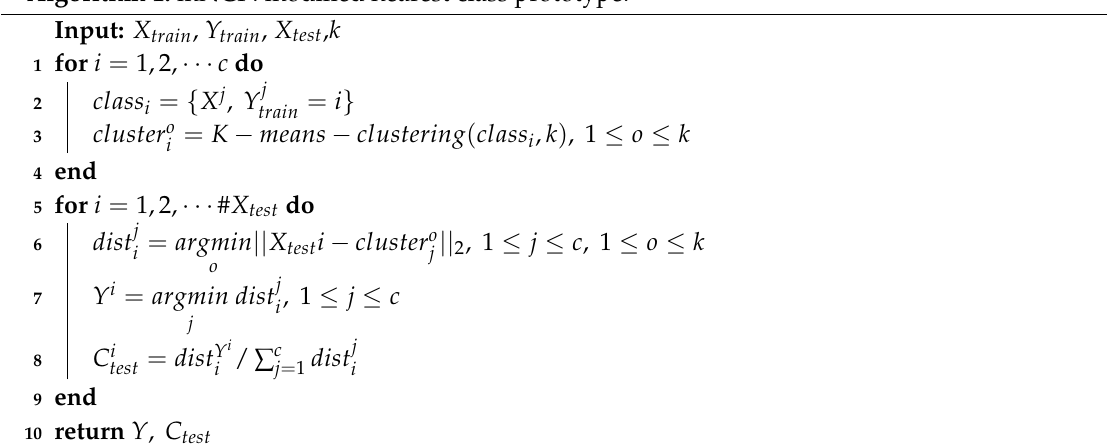
Algorithm 1: mNCP: modified nearest class